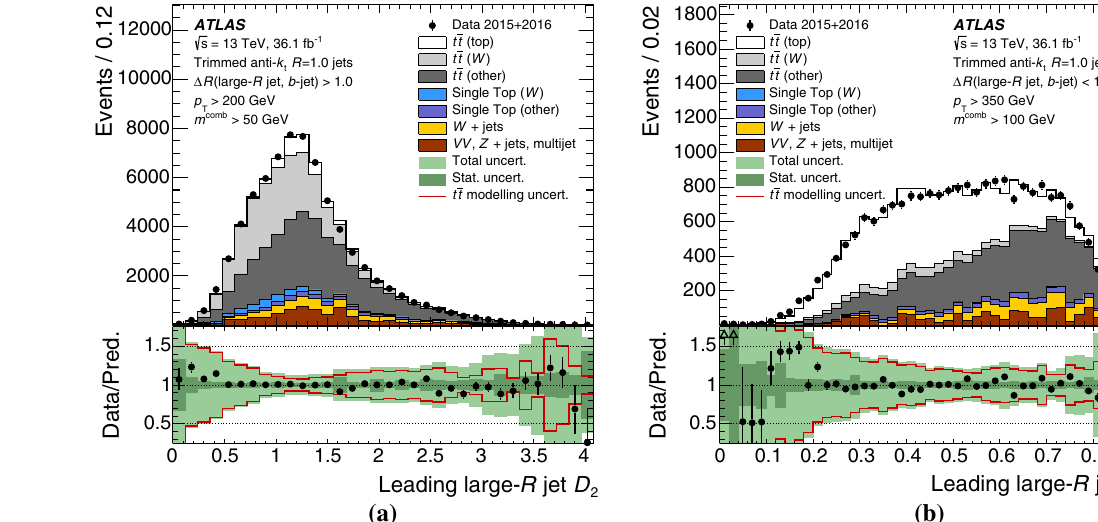
criteria described in Sect. 4.2. The statistical uncertainty of the back- groundprediction(Stat.uncert.)resultsfromlimitedMonteCarlostatis- tics as well as the limited size of the data sample used in the data-driven estimation of the multijet background